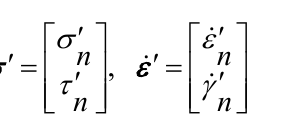
Figure 10: Simulation results for different normal loads ( σ u : a) variations of shear stress, b) variations of dilatancy t